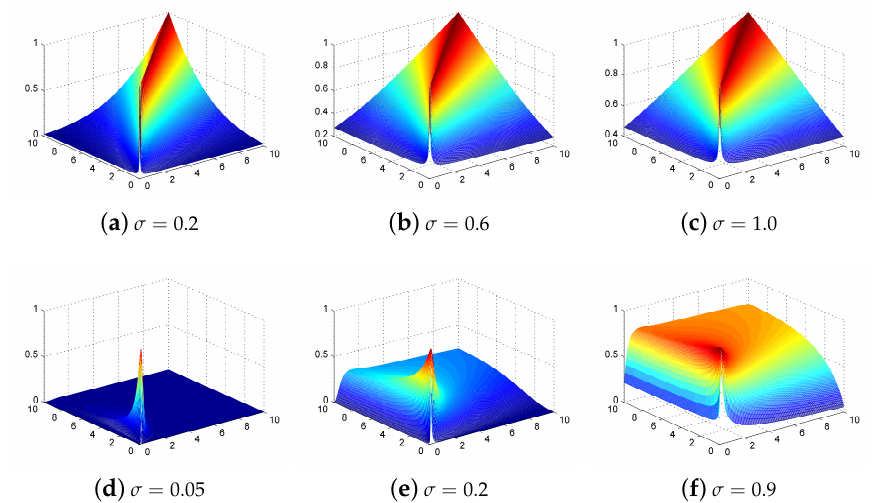
Figure 2. Spectral angle mapper (SAM)-RBF kernel and spectral information divergence (SID)-RBF kernel representation. SAM-RBF kernel with parameter σ values of ( a ) 0.2, ( b ) 0.6, and ( c ) 1.0. SID-RBF kernel with parameter σ values of ( d ) 0.05, ( e ) 0.2, and ( f ) 0.9.